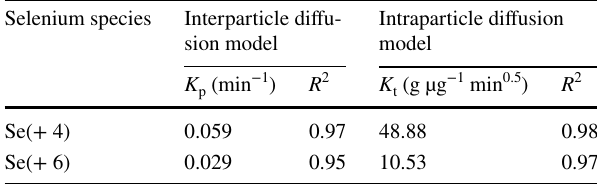
Table 3 Diffusion parameters for selenite and selenate adsorption onto MAA Selenium species